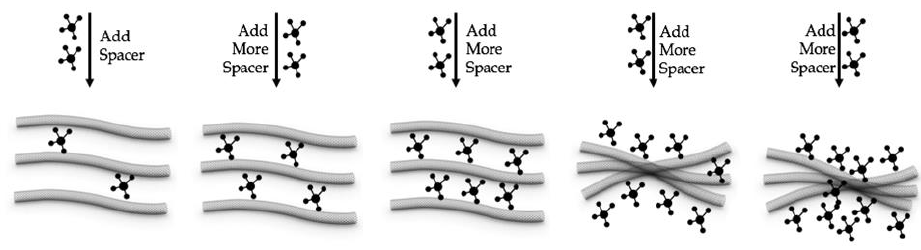
Figure 4. Molecular spacers bind to CNTs at low concentrations. As the ionic strength increases, a higher spacer concentration collapses the EDL repulsion and the CNTs aggregate.